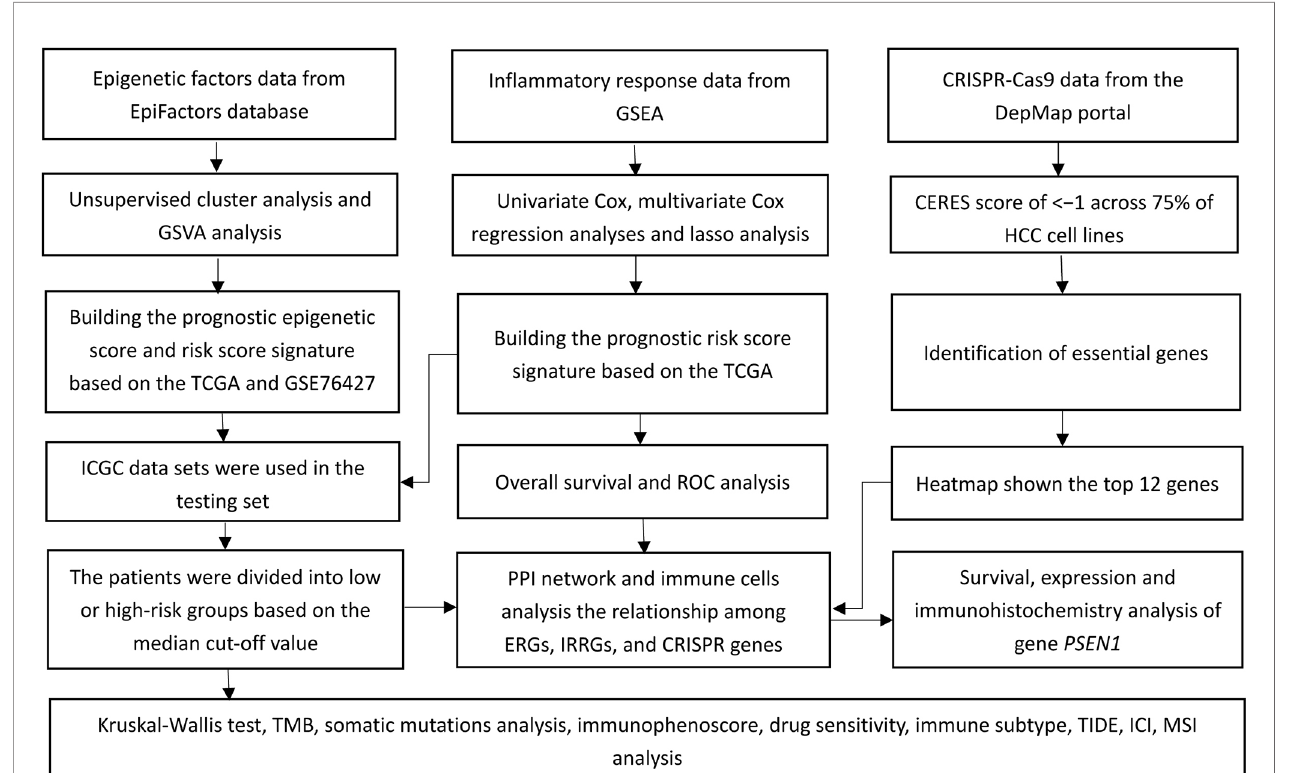
FIGURE 1 | A fl ow chart of the